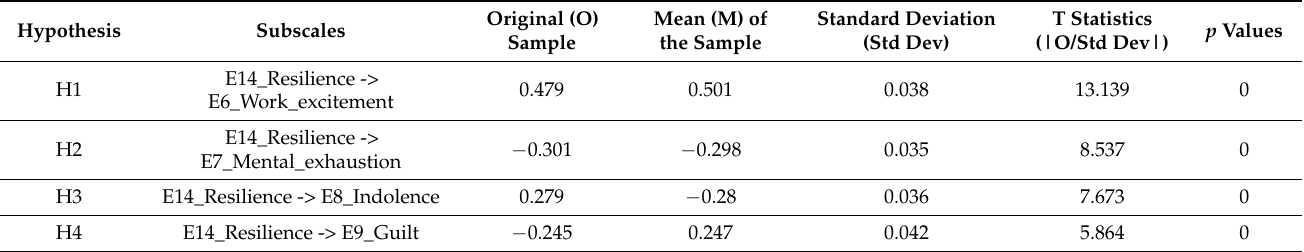
Table 5. Bootstrapping of the final structural equations modeling.